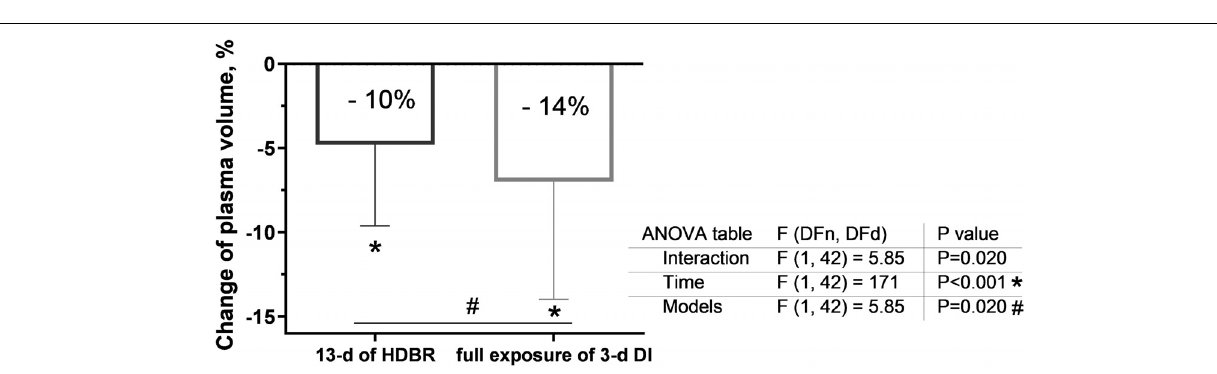
slightly decreased. On the first ( p < 0.01), second ( p < 0.01), third ( p < 0.01), sixth ( p = 0.01), seventh ( p < 0.01), eighth ( p = 0.03), and 13th ( p = 0.01) days of HDBR, the heart rate was significantly